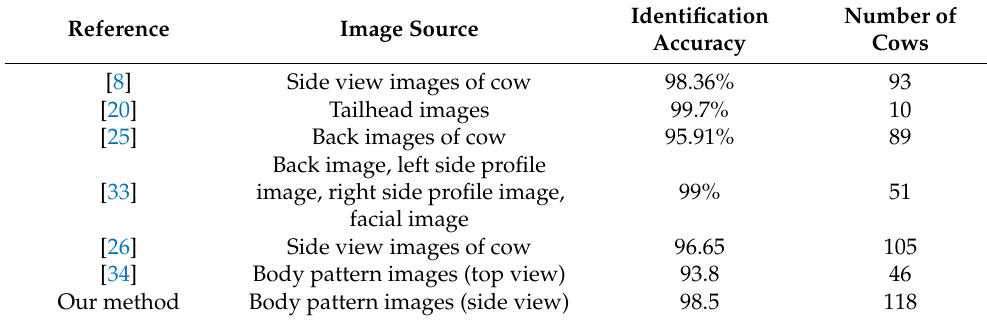
Table 6. Comparison between our proposed method and some of state-of-the-art methods in term of image source, identification accuracy, and number of cows in the datasets. Reference Image Source